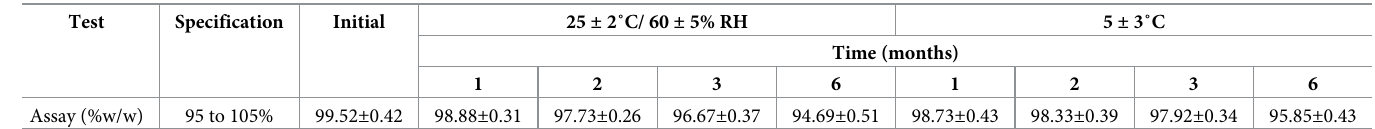
Table 2. Stability studies data of stealth liposome formulation CL13 as per ICH guidelines.